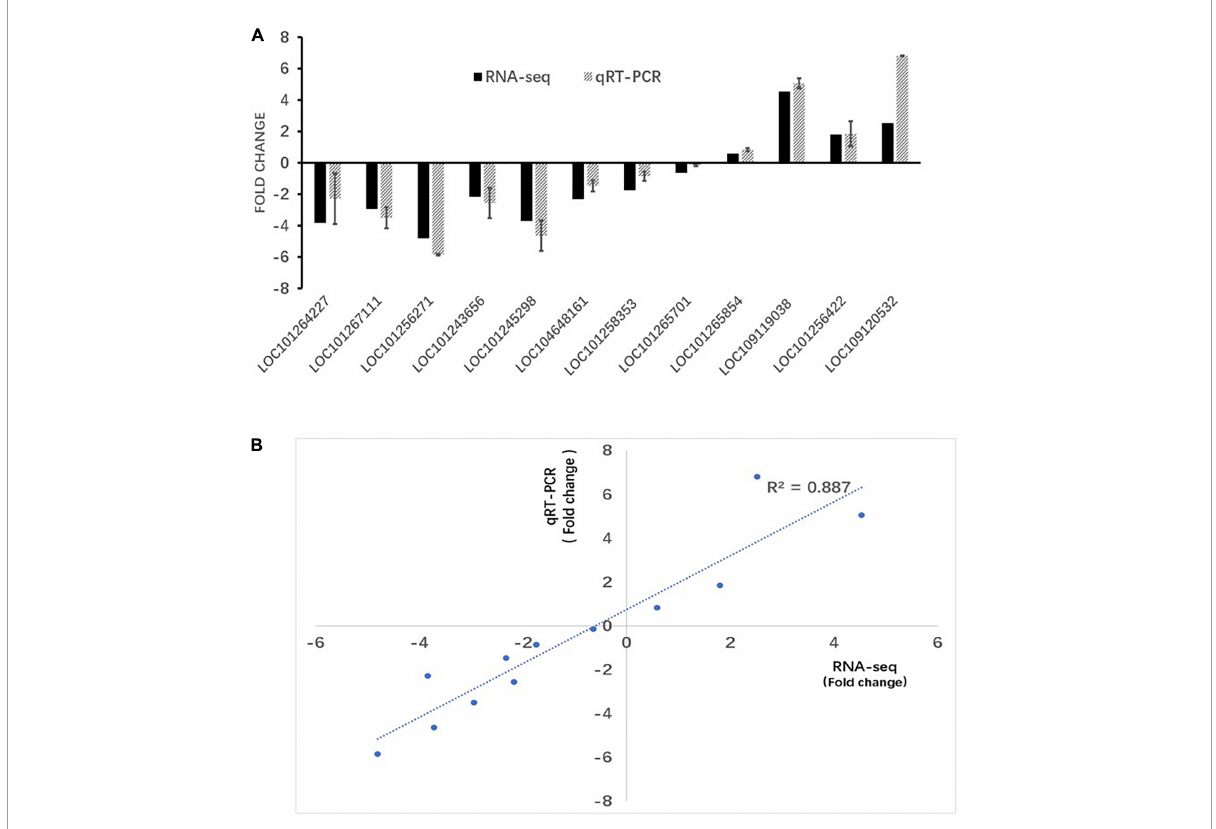
FIGURE7 RT-PCR verification of RNA-seq results. (A) RT-qPCR and RNA-seq comparison between 12 randomly selected differentially expressed genes (DEGs). The RT-qPCR values represent mean ± SEM from three biological replicates. (B) Regression analysis of gene expression ratios compared by RT-qPCR and RNA-seq